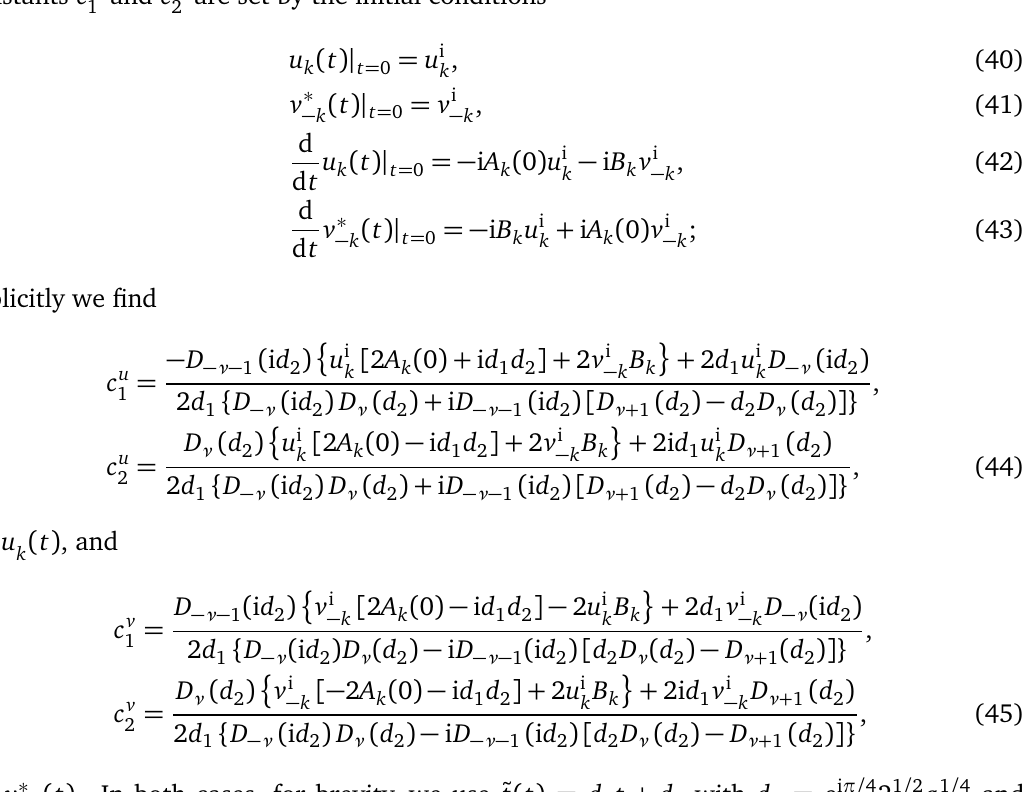
. We observe that n f k